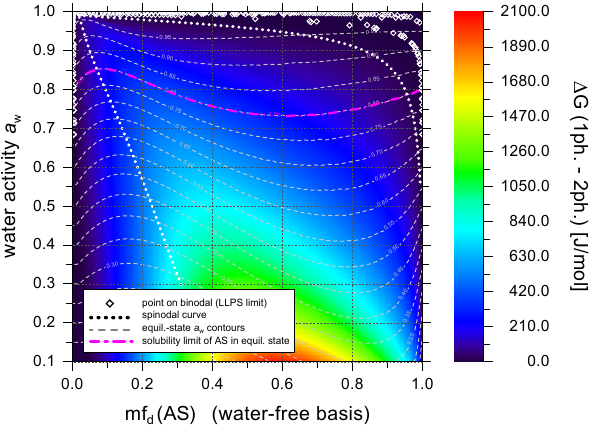
Fig. B1. Computed phase diagram of the 16-component system “ α - pinene SOA products + water + ammonium sulfate (AS)” in the liquid PM, based on the method of Zuend et al. (2010). Conditions: T = 298 K, fixed molar ratios of relative organic compound abun- dances as derived from equil. case gas-particle partitioning calcu- lation at 80% RH, moderate SOA loading, and λ = 10%. Shown is a point-by-point mapping of the 16-dimensional phase compo- sition space to a 2-D representation: water activity vs. mass frac- tion of AS in the “dry” (on water-free basis) mixture of organics + AS, mf d (AS). The color-axis shows the Gibbs energy difference between a forced one-phase (non-ideal) calculation and the equilib- rium state calculation, showing LLPS up to high water activity, i.e. high